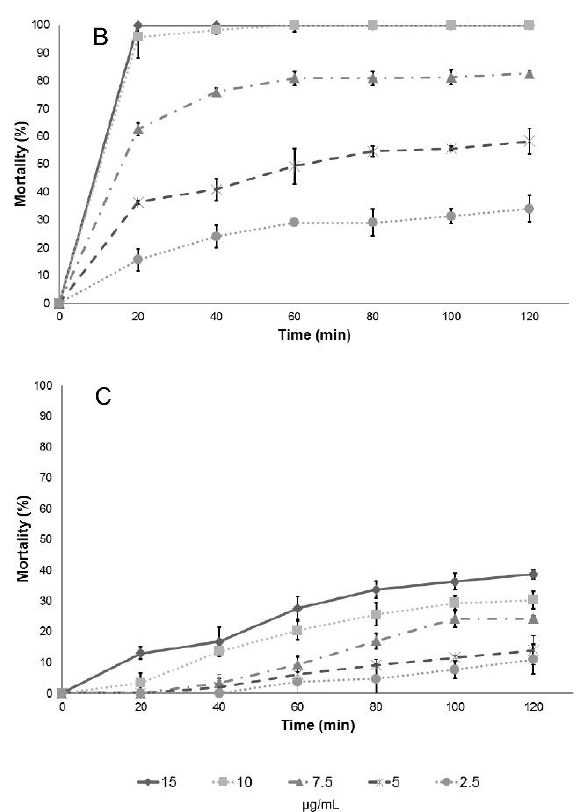
Figure 3. Effect of dose and incubation time on larval mortality of: L. berlandieri Schauer essential oils ( A ); and its major constituents: carvacrol ( B ); and thymol ( C ).